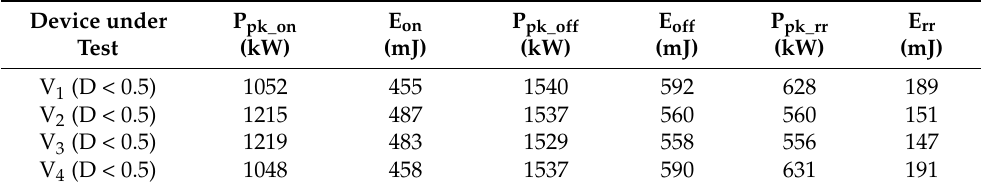
Figure 22. Influence of active switch position of inner commutation loop. ( a ) Detail waveforms of IGBT and FWD during IGBT turn-on. ( b ) Detail waveforms of IGBT and FWD during IGBT turn-off. Table 8. The switching parameters’ comparison with different active switch positions and the same commutation path.